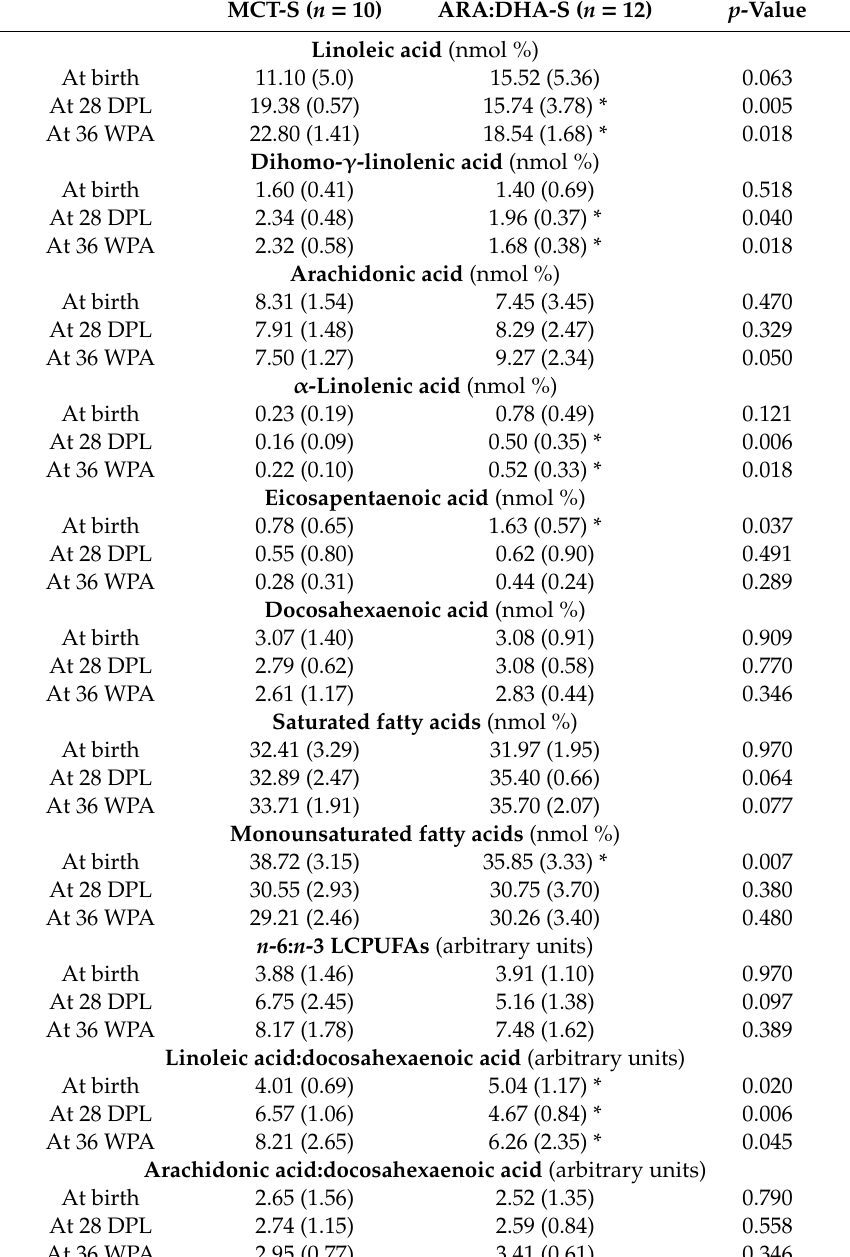
Table 3. Levels of long-chain polyunsaturated fatty acids (LCPUFAs) and ratios at di ff erent points according to